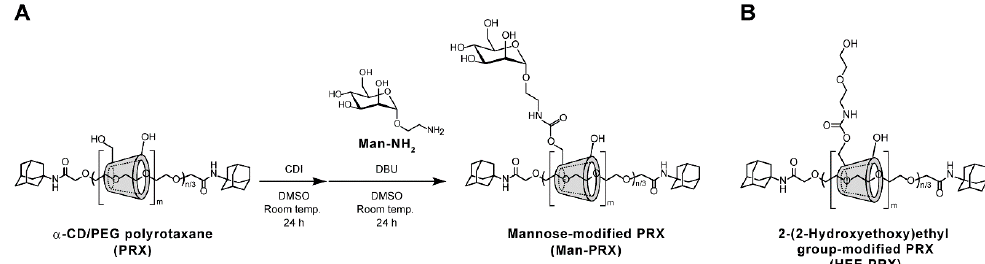
Figure 1. ( A ) Scheme for synthesizing α - D -mannose-modified α -CD/PEG-based PRX (Man-PRX) and ( B ) chemical structure of 2-(2-hydroxyethoxy)ethyl carbamate-modified PRX (HEE-PRX), where n and m denote the polymerization degree of the PEG axle and the number of threaded α -CDs, respectively.